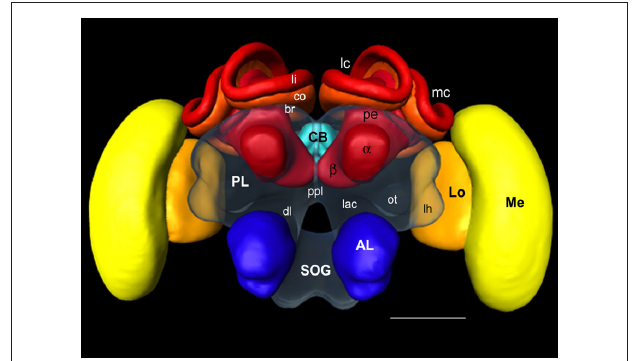
Figure 1 | Surface reconstruction of the honeybee standard brain (HSB). Neuropil areas defined in the HSB are shown in different colors. Components of the midbrain area (protocerebral lobes, PL, and subesophageal ganglion, SOG) are fused and shown in transparency. Subcompartments of the protocerebral lobe and mushroom bodies are indicated in lower case letters. Scale: 300 μm. PL: protocerebral lobe; ppl: posterior protocerebral lobe, Lo: lobula; Me: medulla, li: lip, co: collar, br: basal ring, lh: lateral horn, ot: optic tubercle, lac: lateral accessory lobe, mc: median calyx, lc: lateral calyx, pe: peduncle, α : alpha-lobe, β : beta-lobe, SOG: suboesophageal